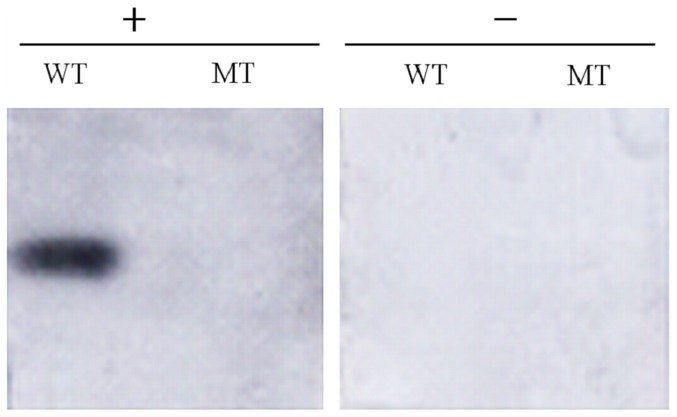
Western-blotting analysis of the expression of Rmp protein in wild-type and Rmp deletion mutant strains of N. gonorrhoeae.Lysates of wild-type (WT) and mutant (MT) strains were subjected to SDS-PAGE and were transferred to PVDF membranes to react with anti-rrRmp (+) and normal mouse serum (–), respectively.